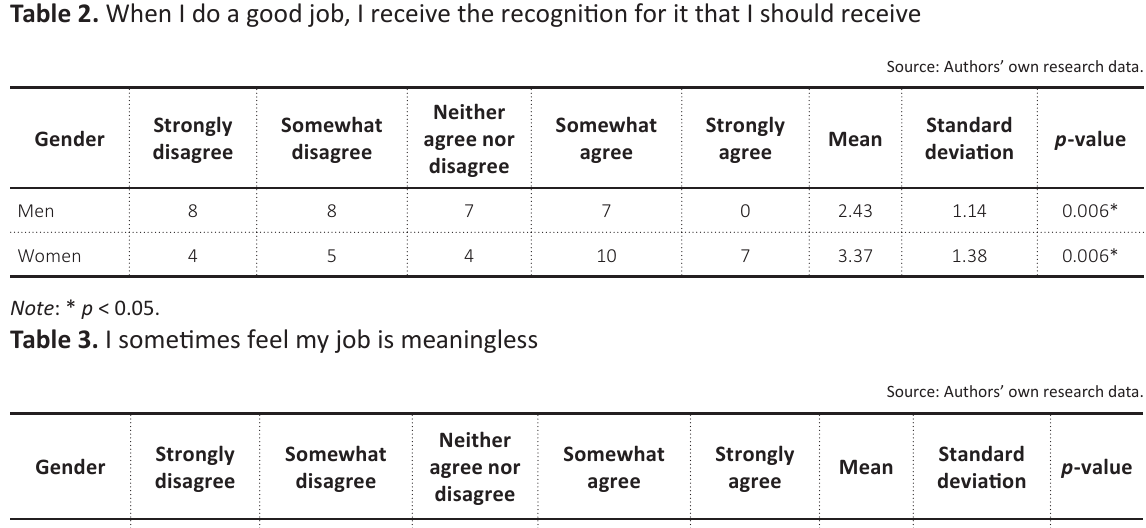
Table 2. When I do a good job, I receive the recognition for it that I should receive